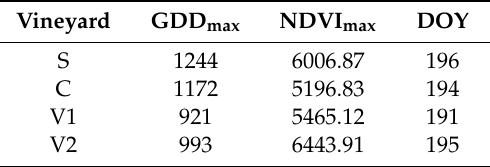
Table 5. Values of NDVI max , GDD max and DOY (when NDVI max is reached) as estimated by the models of Table 4 for S, C, V1 and V2 vineyards. Expected values of GDD max s at NDVI max .